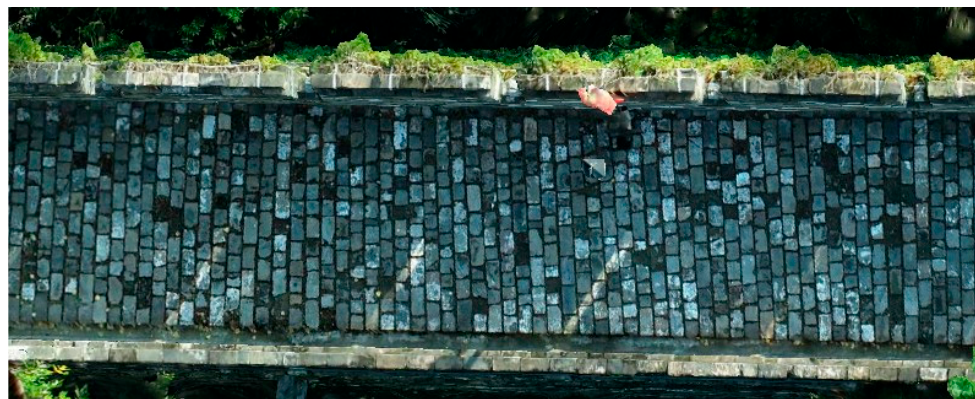
Figure 14. Orthophotomosaic of the city wall. (The top view shows the corridor at the top of the city wall for tourists to walk on).